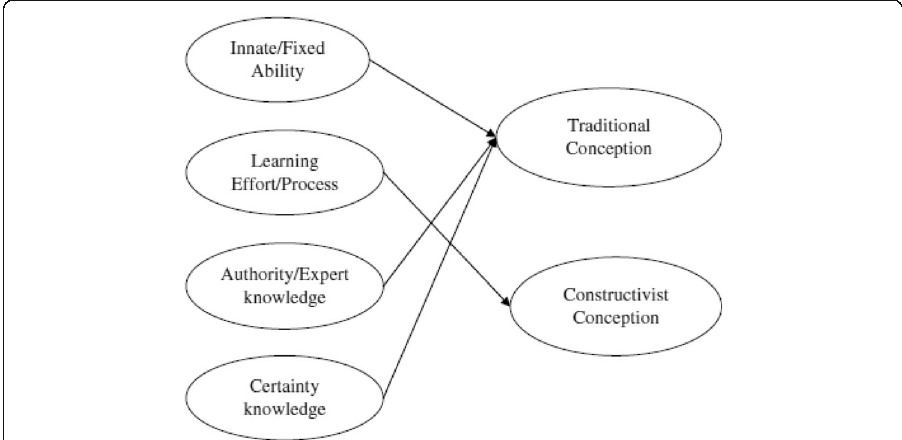
Fig. 1 Path model highlighting the possible relation between teachers' EB and conception of teaching and learning (adapted from Chan & Elliott,